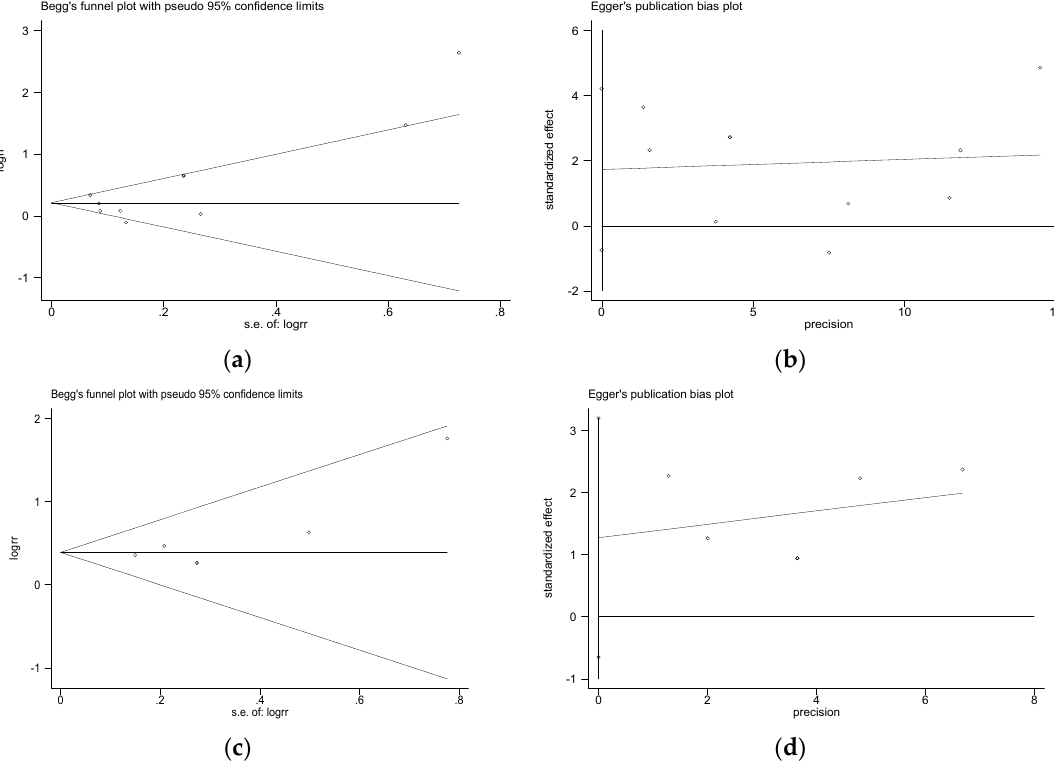
Figure 9. Publication bias in depression and anxiety symptoms.